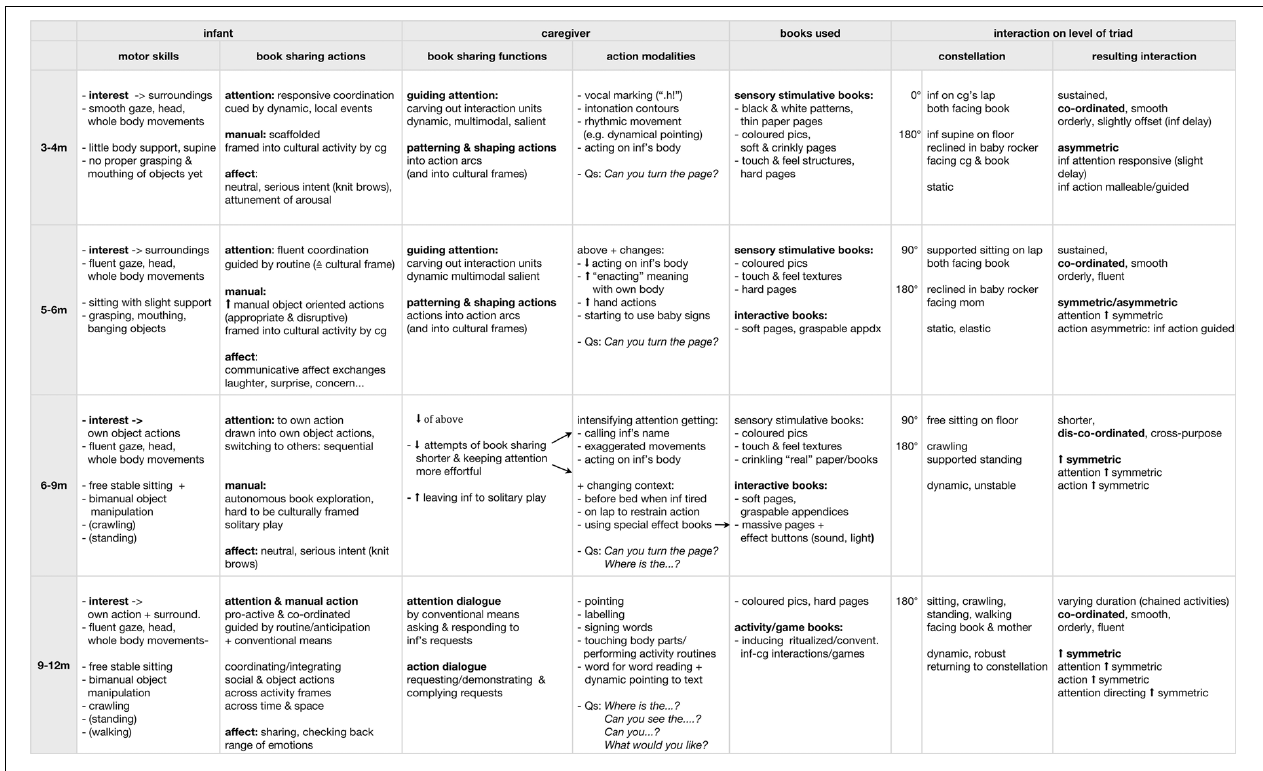
FIGURE 12 | Ecologies in transformation. The table gives an overview of book sharing as it changes over the first year. The columns list relevant characteristics for the respective participants: infant (inf): motor skills and book sharing actions sorted in attentional, manual and affective; caregiver